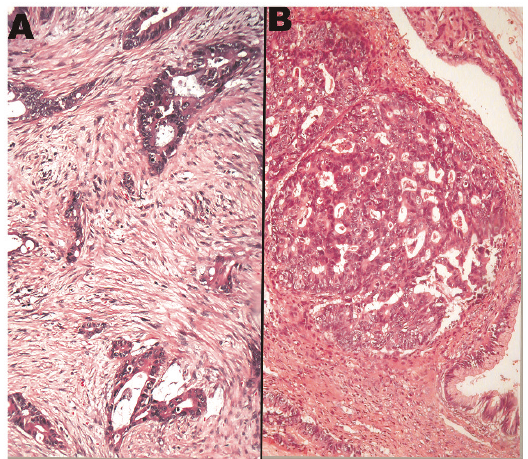
Figure 1 - Patterns of invasion in two mucinous adenocarcino- mas: infiltrative/destructive (A) and confluent with nodular configuration (B).